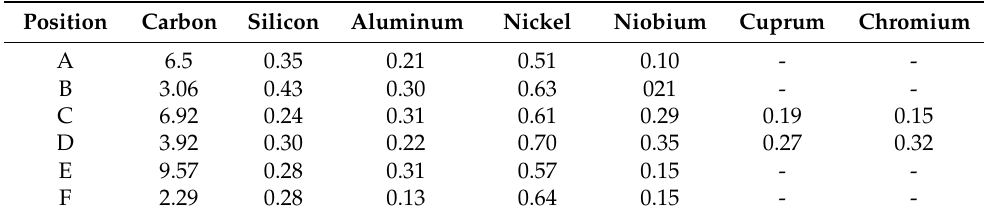
Table 2. EDS results in Figure